Question: In a single sentence, describe what this figure presents.
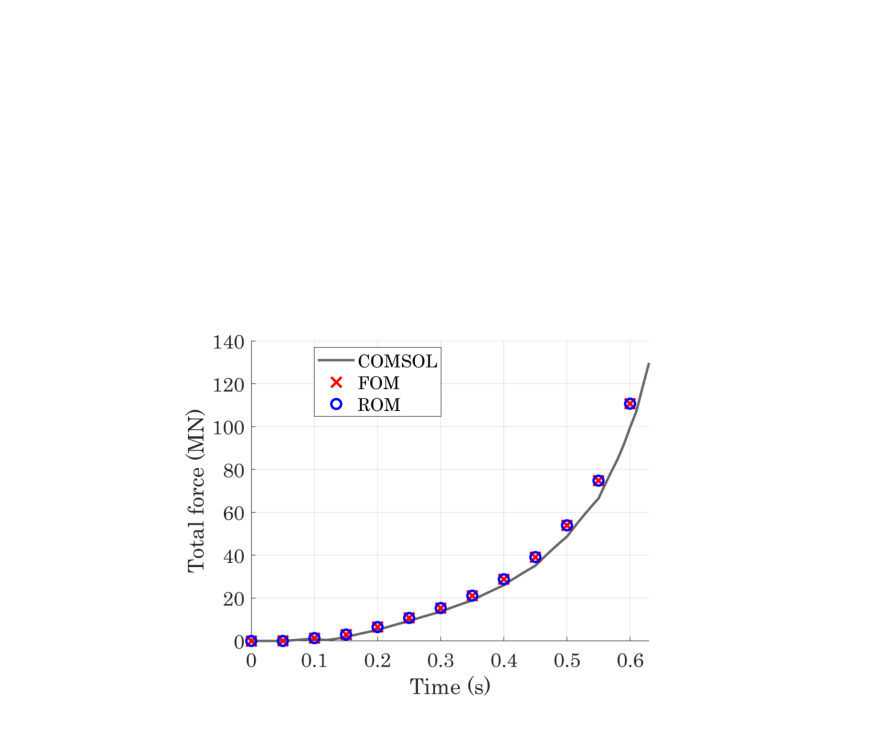
Answer: Trend of total force over the VV during the VDE evaluated with the 2D axisymmetric model in COMSOL®, the FOM, and the ROM.